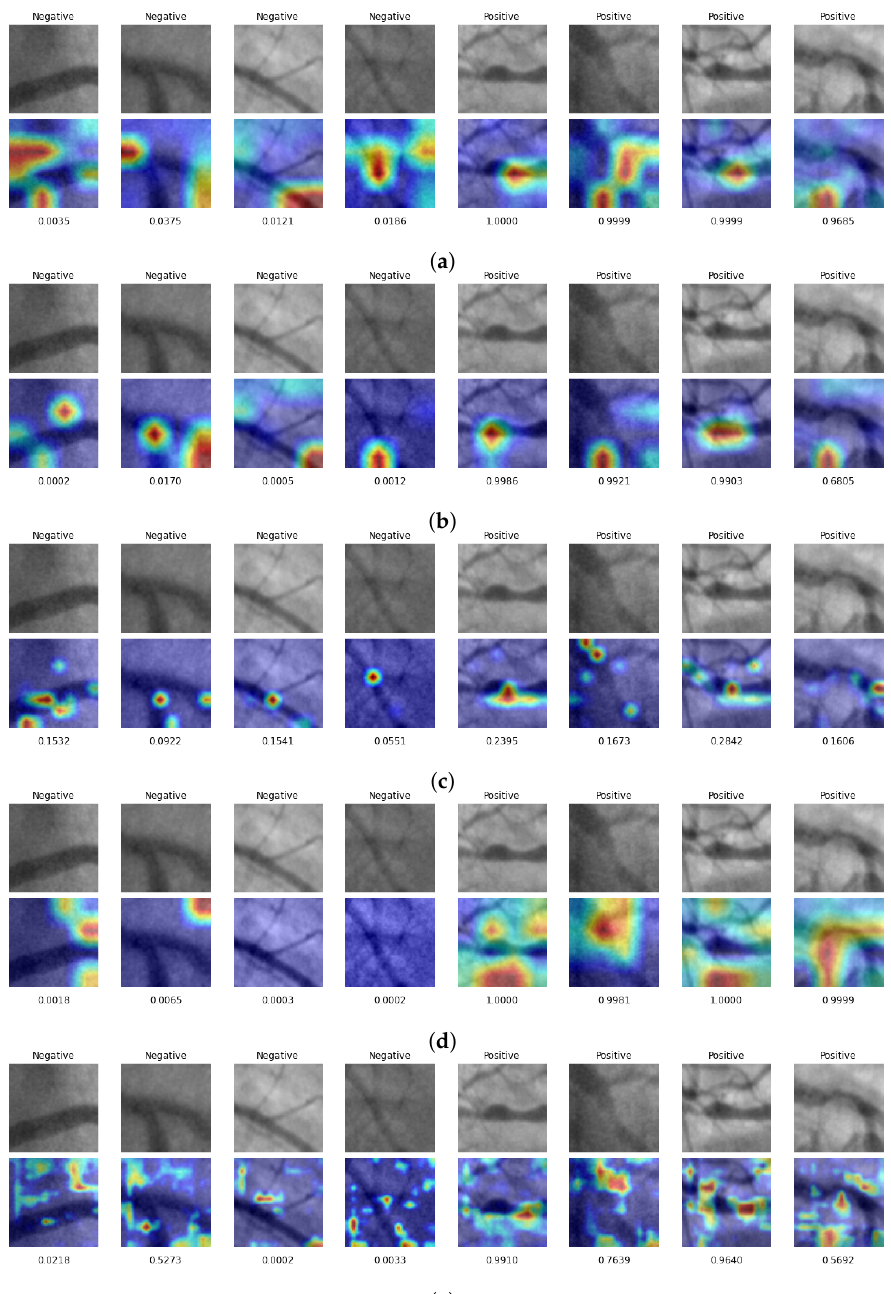
Figure 11. The GradCAM responses for the test subset of the P-ADSD dataset. Four negative and four positive stenosis cases are shown. ( a ) Vanilla ResNet18, ( b ) Vanilla SE-ResNet18, ( c ) Trim SE-ResNet18, ( d ) CBAM-ResNet34, and ( e ) Proposed LRSE-Net. Red tones stand for high attention regions, and purple for low attention. Bellow each image, the probability of stenosis is set. For values greater than 0.5, the models classify as stenosis